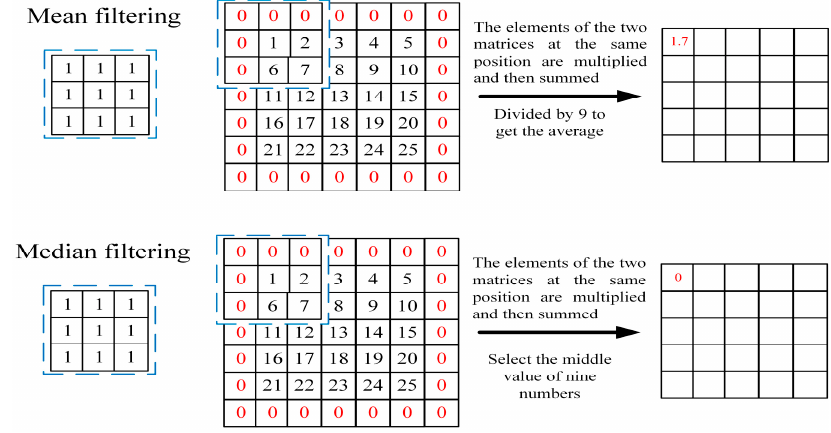
Figure 1. Difference between mean filtering and median filtering.